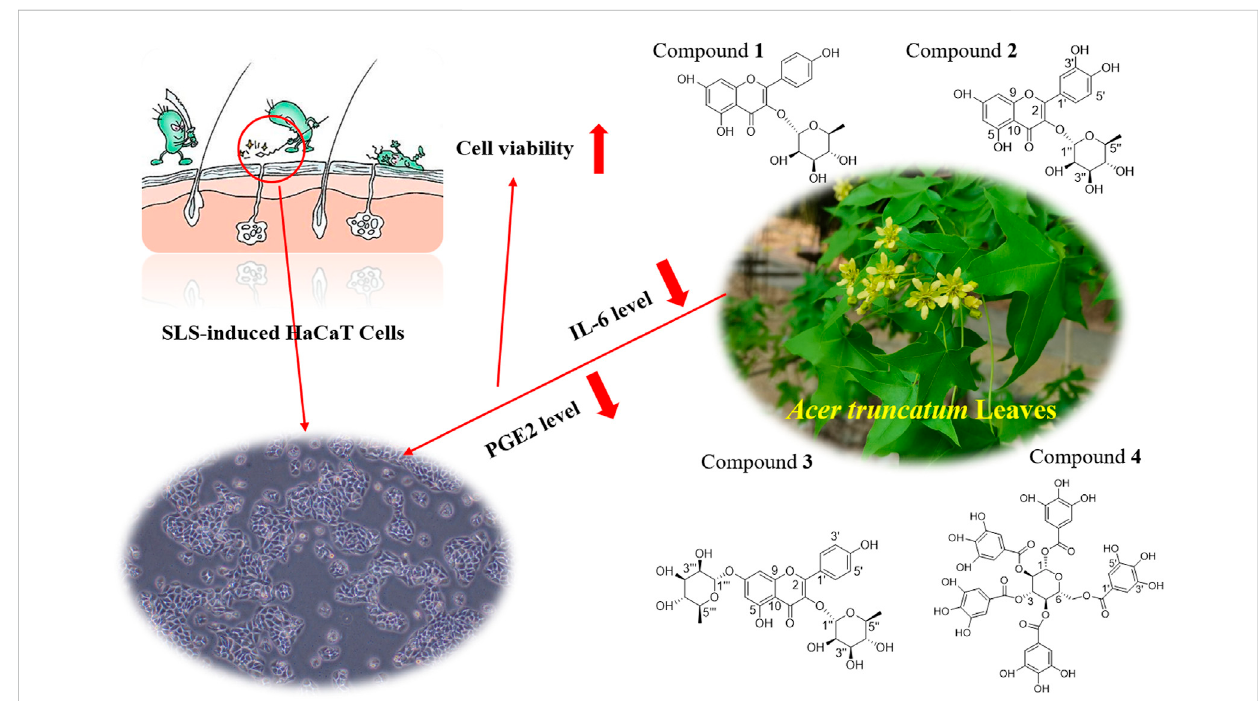
Underlying potential mechanism of the anti-in fl ammatory effect of A. truncatum leaves. The anti-in fl ammatory effect of A. truncatum leaves might be associated with downregulation of IL-6 and PGE2. Four fl avonoids from A. truncatum leaves may contribute to its anti-in fl ammatory